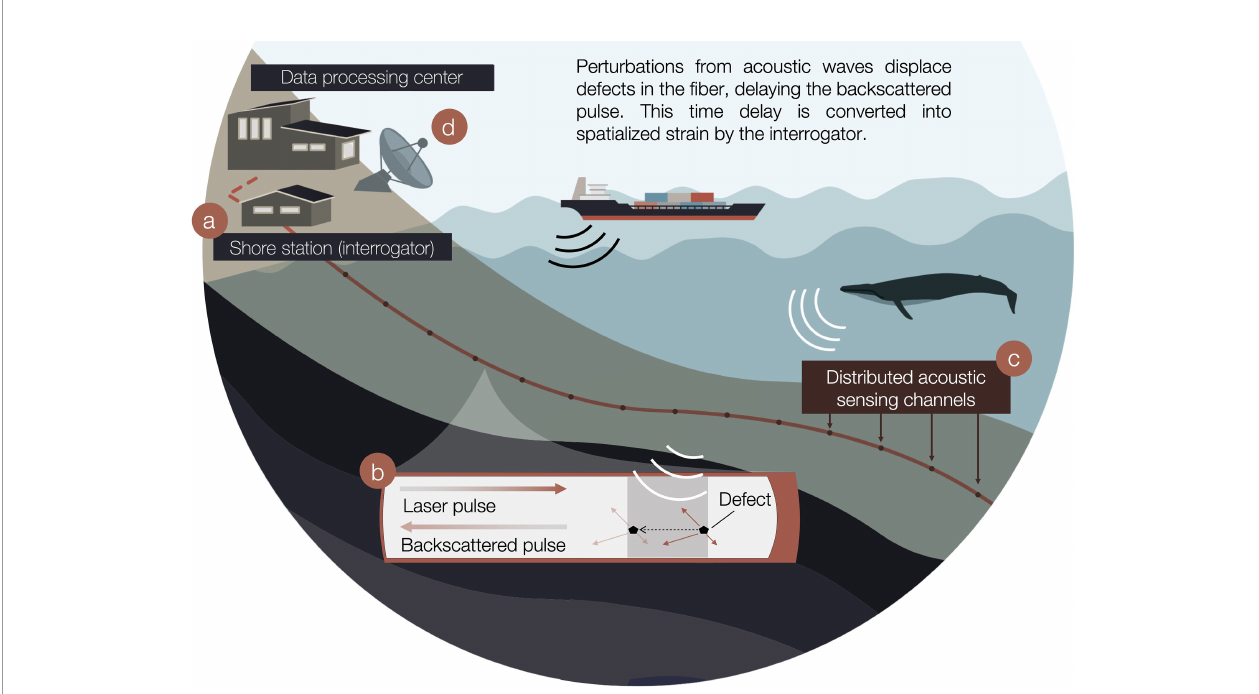
FIGURE 1 | Distributed acoustic sensing (DAS) for baleen whale monitoring. (A) On shore, an interrogator is connected to one end of an existing fi ber optic cable to repurpose it into DAS. (B) It interrogates the fi ber by sending laser pulses that are backscattered by anomalies while simultaneously, these defects are shifted under the effect of incoming acoustic waves. (C) The interrogator calculates time delays of the backscattered response at regularly spaced intervals along the fi ber, named channels. Time delays are averaged over the gauge length and converted into longitudinal strain waveforms analogous to acoustic pressure. (D) DAS two- dimensional data is streamed in near-real-time to a remote data processing